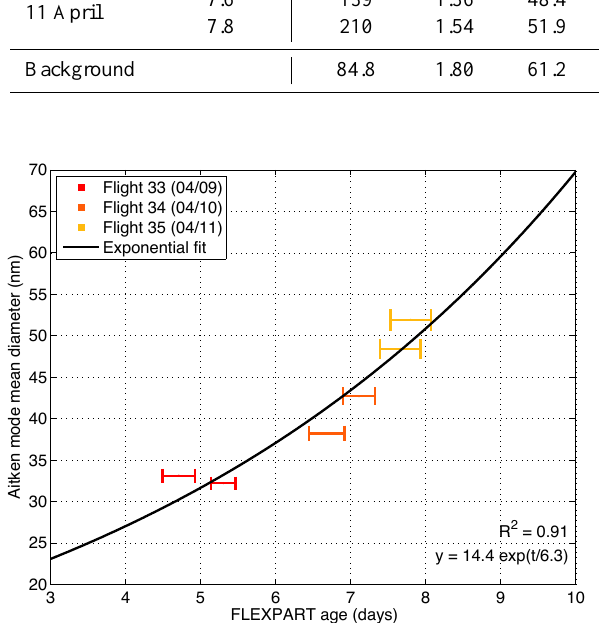
Fig. 5b. Evolution of the SMPS concentration (20–450nm) as a function of the FLEXPART age for the anthropogenic plume. Data points are colour coded with respect to flight dates and an exponen- tial fit is shown as a black